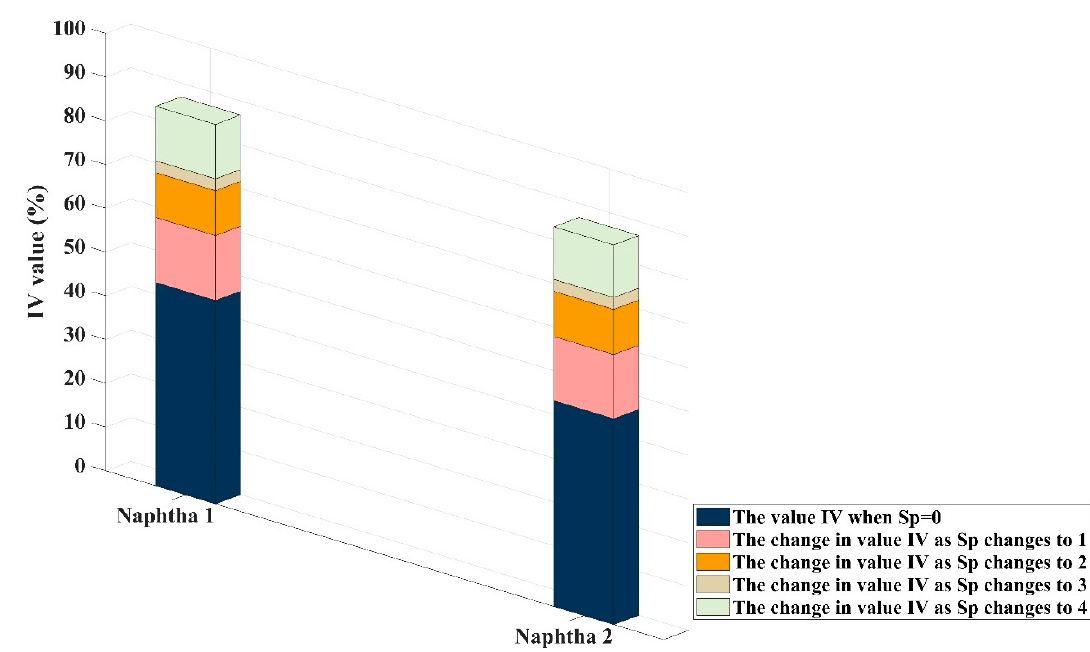
Figure 6. The IV SP = k value of di ff erent S p Figure 6. The 𝐼𝑉 (cid:2903)(cid:2900)(cid:2880)(cid:3038) value of different S p .